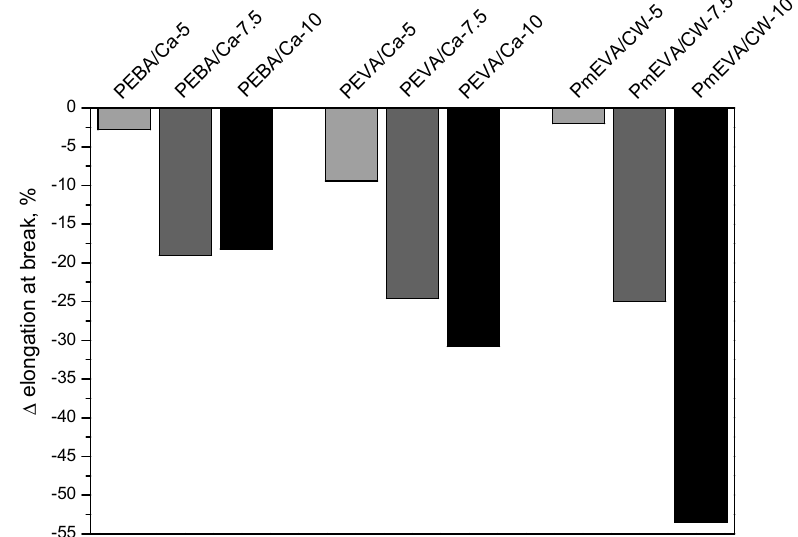
Figure 3. Influence of a MMT pre-dispersion type and MMT content (5, 7.5 or 10 wt. %) on elongation at break value of PE composites.